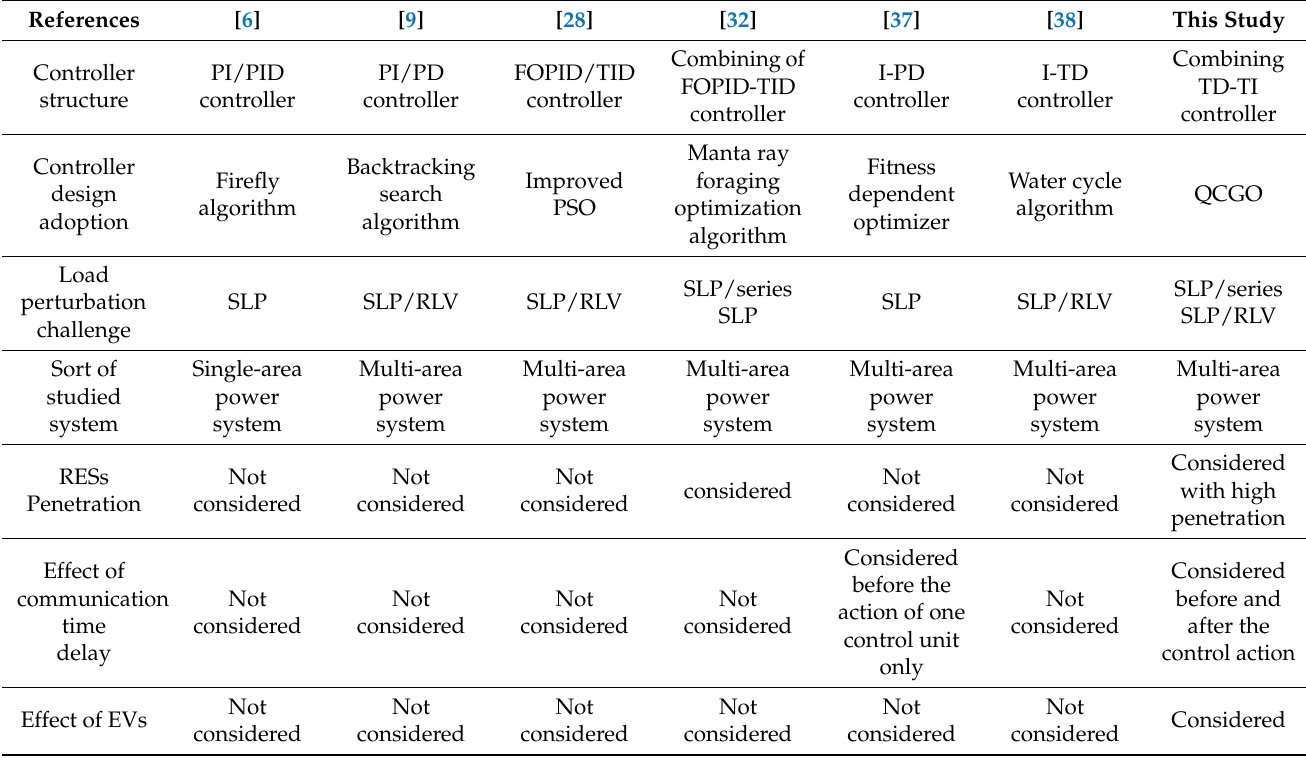
Table 1. The motivation of current work compared with other published